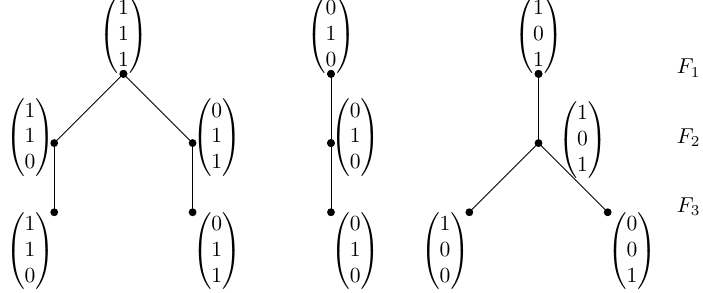
Figure 5. F with assigned result vectors for each